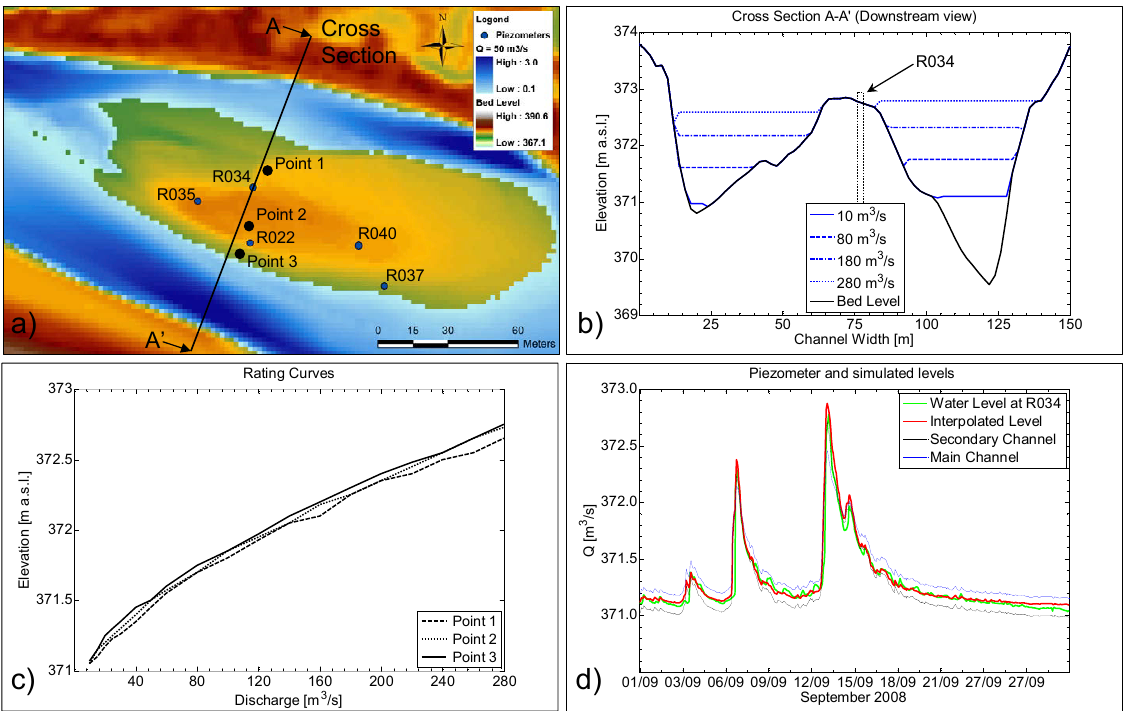
Fig. 8. Cross section across the central gravel bar (transect C in Fig. 2): (a) plan view; (b) profile of surface elevation (ma.s.l.) and water depth (m) as function of river discharge shown in flow direction; (c) corresponding rating curves, (d) comparison between measured and interpolated groundwater heads in monitoring well R034.